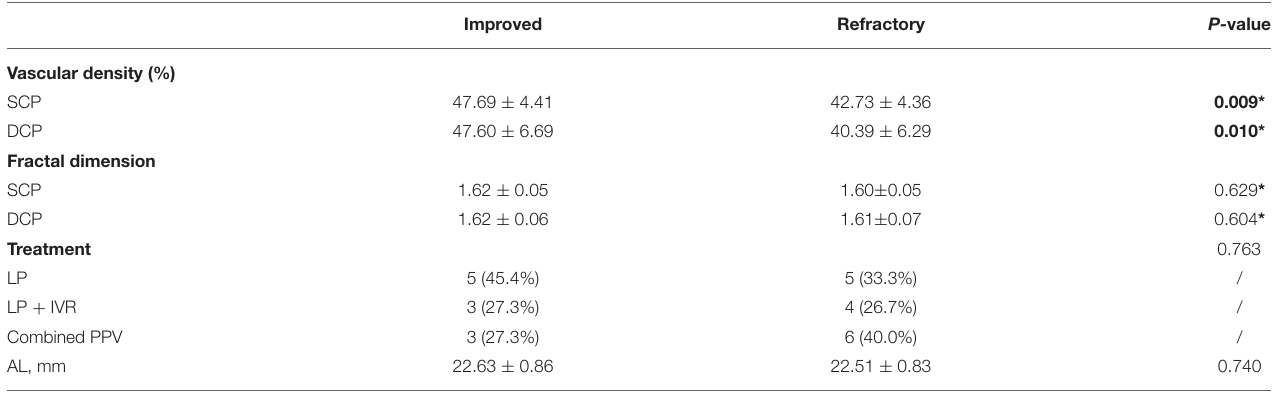
TABLE 4 | The association of macular vascular variables at baseline with the intractable nature of macular